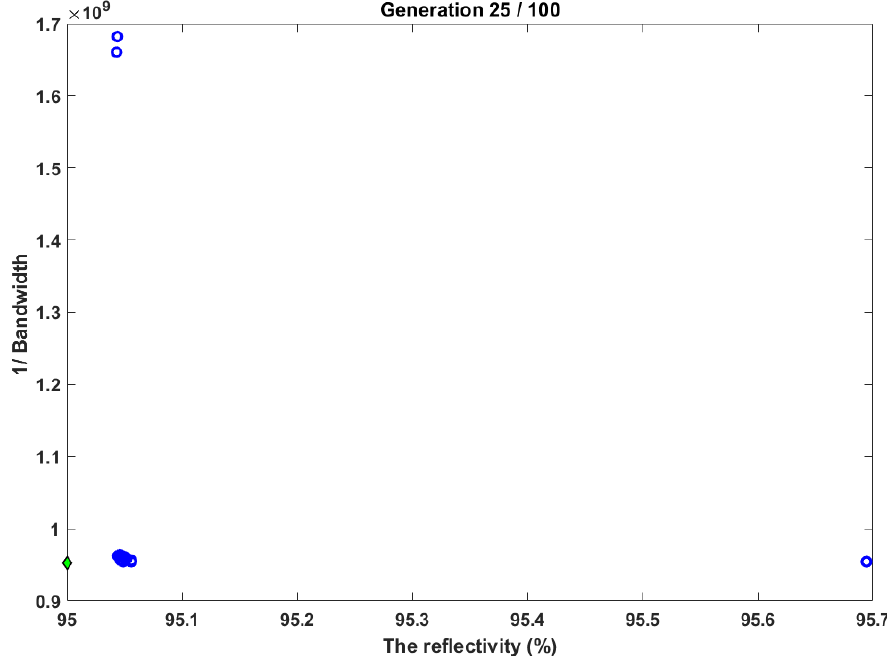
Figure 6. The testing of RNSGA-II for increasing the reflectivity and decreasing the bandwidth.